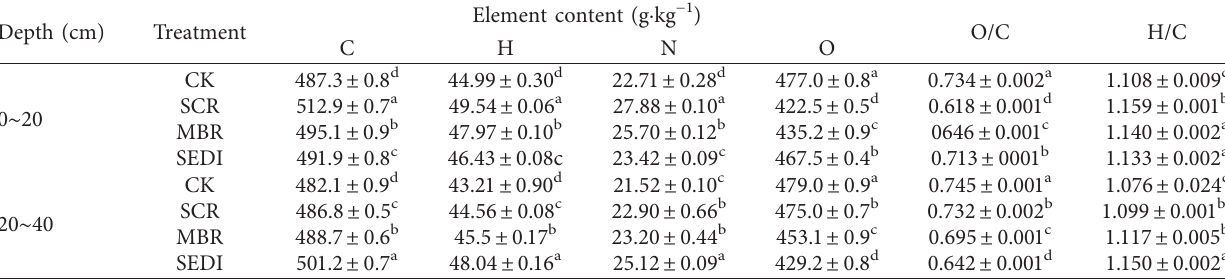
Table 3: Effect of straw returning to the field on HA element composition in